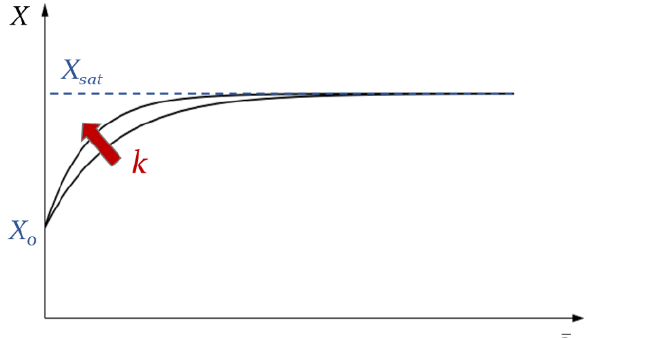
Figure 5. Influences of different parameters on the integrated AF nonlinear evolution function.